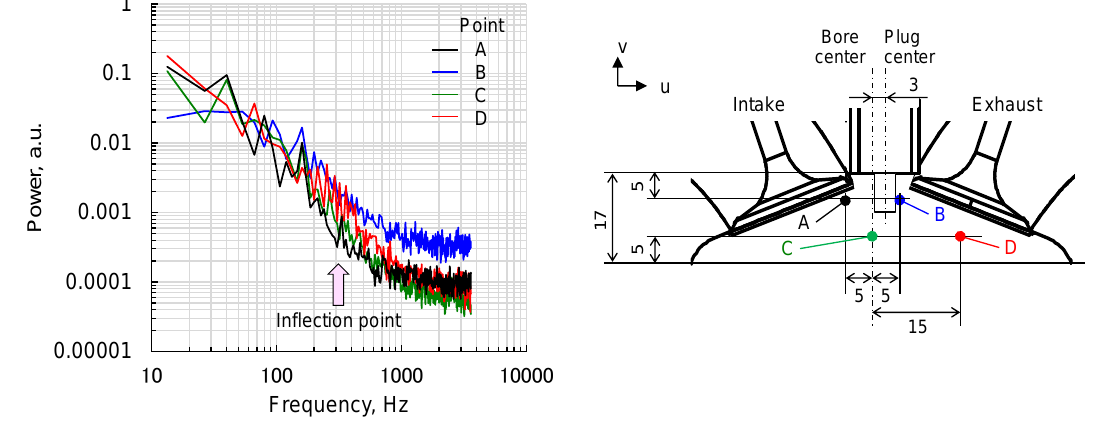
Figure 6. The power spectrum of the instantaneous velocity from PIV of different points in the measurement area.